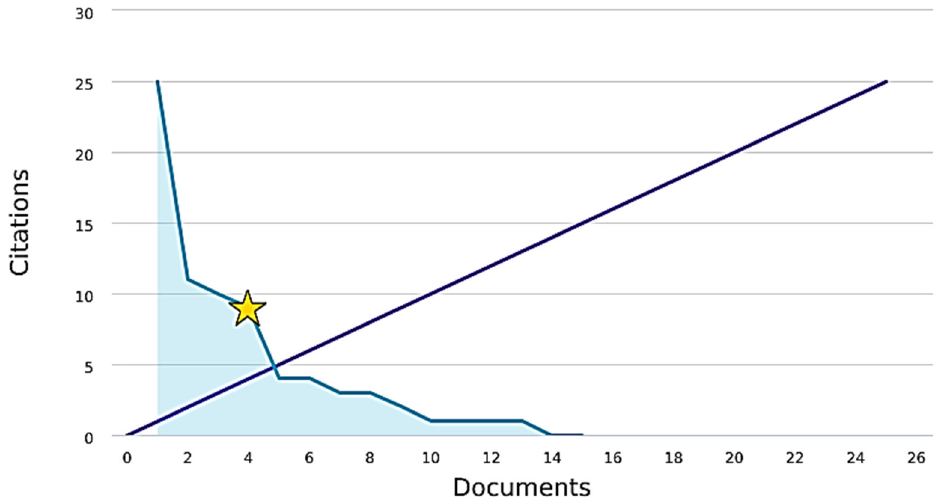
Figure 3. H-index of publications.